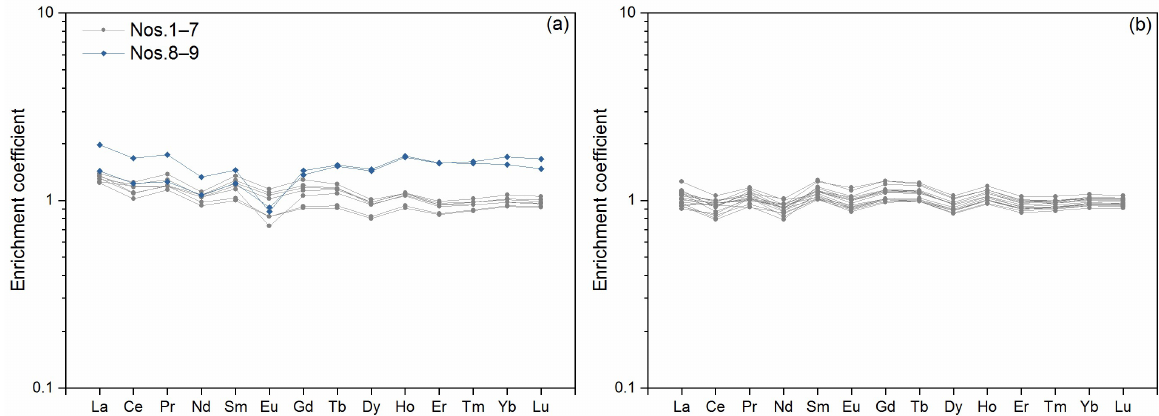
Figure 4. NASC —normalized REEs distribution for the samples from the Wufeng-Longmaxi For- mations ( a ) and the Niutitang Formation ( b ). NASC = The North American shale composite from McLennan (1989) [32] . The enrichment coefficient can be expressed as X sample /X NASC , where X repre- sents the weight concentrations of elements X.